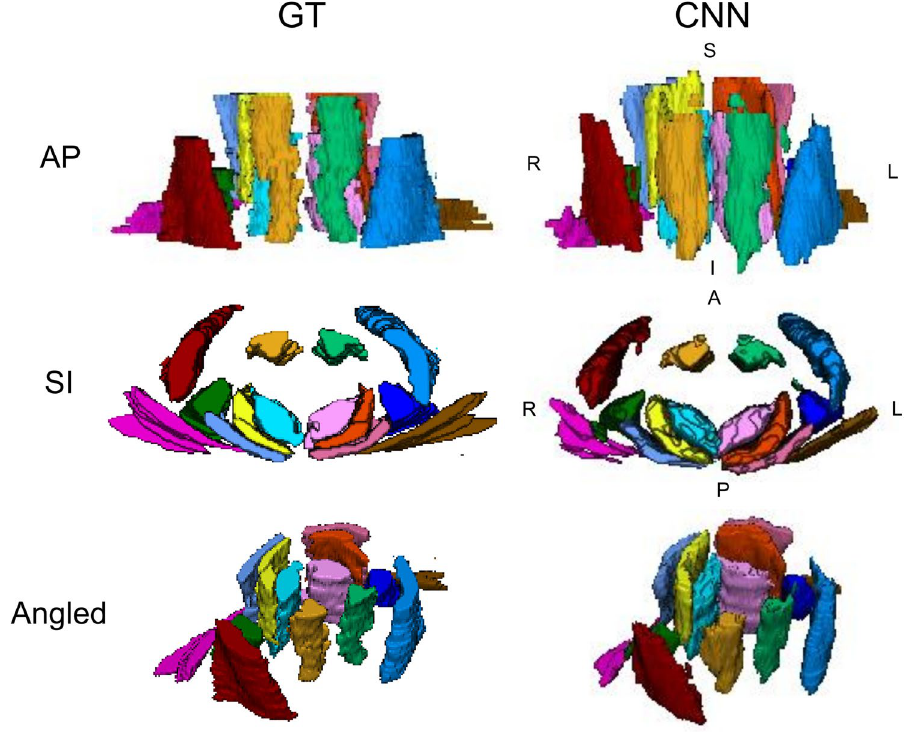
Figure 2. Three-dimensional renderings of the cervical spine muscle segmentations. The ground truth (GT) and convolutional neural network (CNN) segmentations from a randomly selected testing scan are shown as three-dimensional renderings. The muscle groups segmented included the MFSS (left = light pink, right = aqua), LC (left = light green, right = gold), SSCap (left = orange, right = yellow), SPCap (left = dark pink, right = light blue), LS (left = indigo, right = dark green), SCM (left = blue, right = red), and TR (left = brown, right = magenta). See Fig. 1 for the two-dimensional segmentation masks of the GT and CNN overlaid the water-only image. L = left, R = right, A = anterior, P = posterior, S = superior, I =